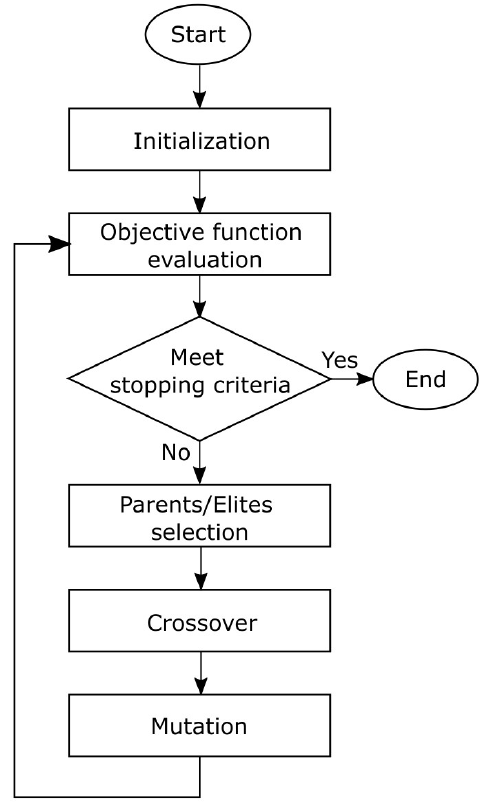
Figure 3. Flowchart of the genetic algorithm (GA).